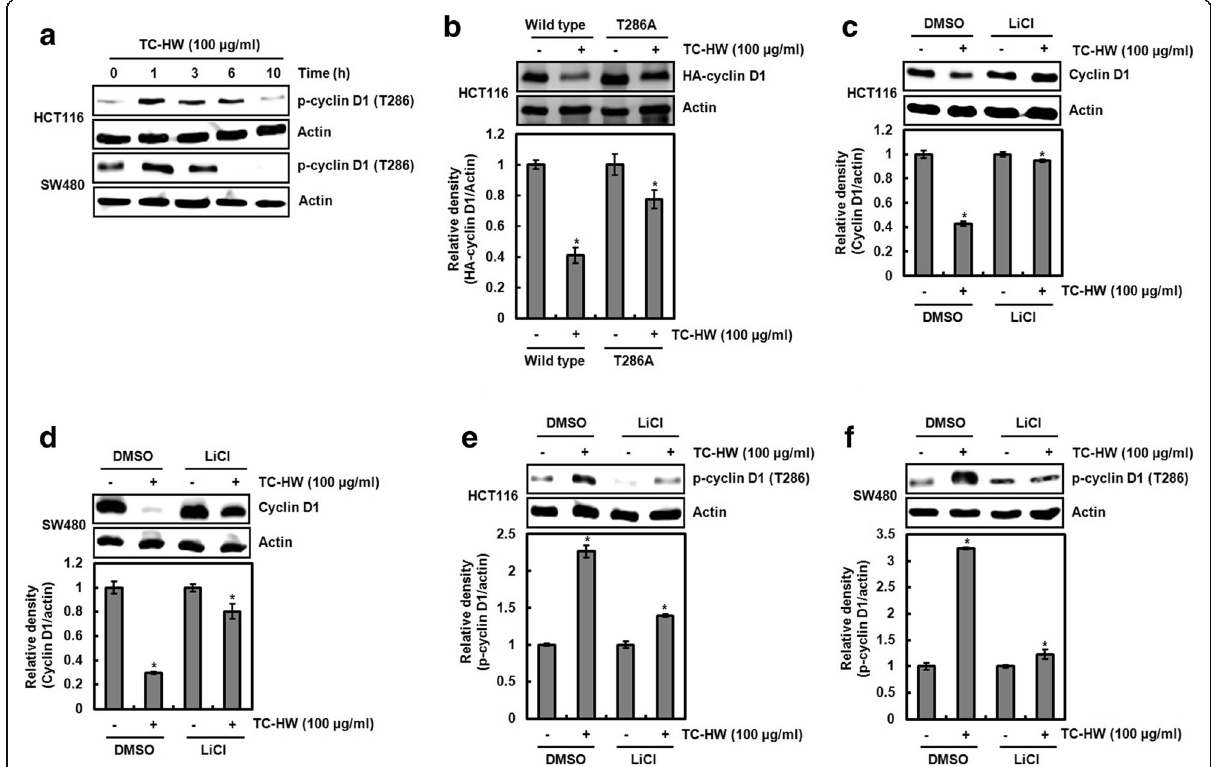
Fig. 2 TC-HW-mediated cyclin D1 degradation dependent on GSK3 β -mediated Thr-286 phosphorylation of cyclin D1. a HCT116 and SW480 were plated overnight and then treated with TC-HW (100 μ g/ml) for the indicated times. Cell lysates were subjected to SDS-PAGE and the Western blot was performed using antibody against phospho-cyclin D1 (Thr-286). Actin was used as internal control for Western blot analysis. b HCT116 cells were transfected with wild type HA-tagged cyclin D1 or HA-tagged T286A cyclin D1 expression vector and then treated with 100 μ g/ml of TC-HW. Cell lysates were subjected to SDS-PAGE and the Western blot was performed using antibody against HA-cyclin D1. Actin was used as internal control for Western blot analysis. * P < 0.05 compared to cell without TC-HW. c and d HCT116 and SW480 cells were pretreated with LiCl (20 mM), and then co-treated with TC-HW (100 μ g/ml). Cell lysates were subjected to SDS-PAGE and the Western blot was performed using antibody against cyclin D1. Actin was used as internal control for Western blot analysis. * P < 0.05 compared to cell without TC-HW. e and f HCT116 and SW480 cells were pretreated with LiCl (20 mM), and then co-treated with TC-HW (100 μ g/ml). Cell lysates were subjected to SDS-PAGE and the Western blot was performed using antibody against phospho-cyclin D1 (Thr-286). Actin was used as internal control for Western blot analysis. * P <